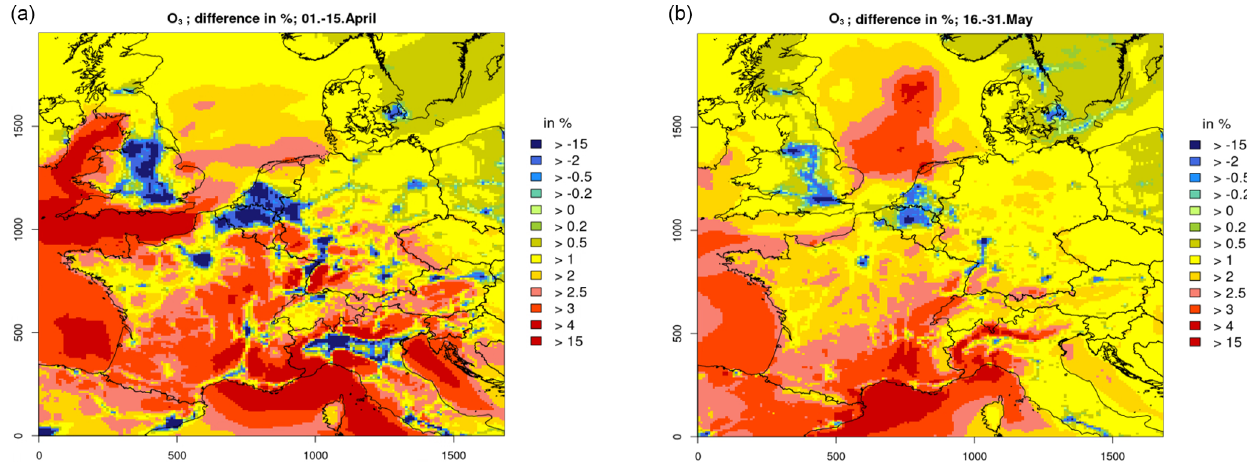
Figure 12. CMAQ results for changes in O 3 concentrations due to lockdown measures in central Europe between 1 and 15 April 2020 (a) and 16–31 May 2020 (b) . Positive values denote concentration reductions, and negative values denote concentration